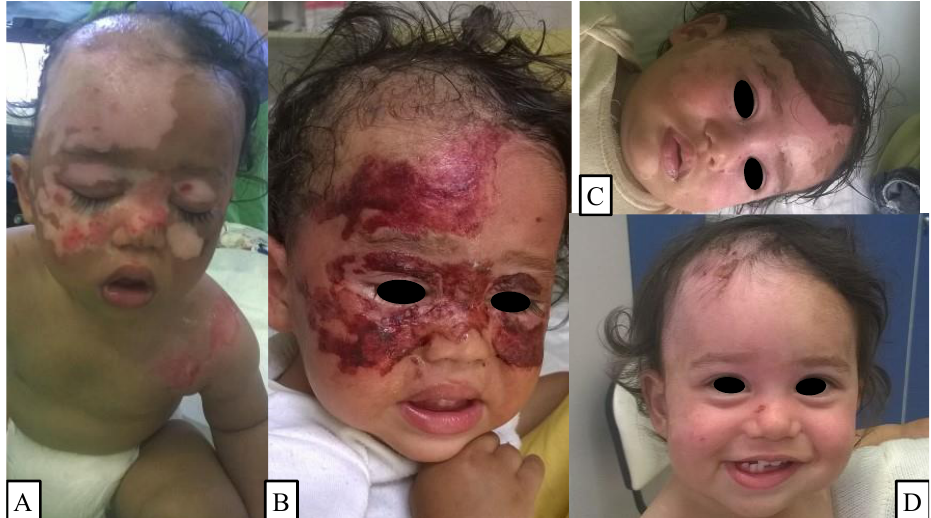
Figure 1. ( A ) A child had bullectomy and debridement performed in general anesthesia on the first day of injury. ( B , C ) On the third- and sixth-day control appointment, the patient showed signs of skin regeneration and reduction in wound size, which was covered with the biological membrane. ( D ) The 12-day follow-up revealed almost complete reepithelialization.